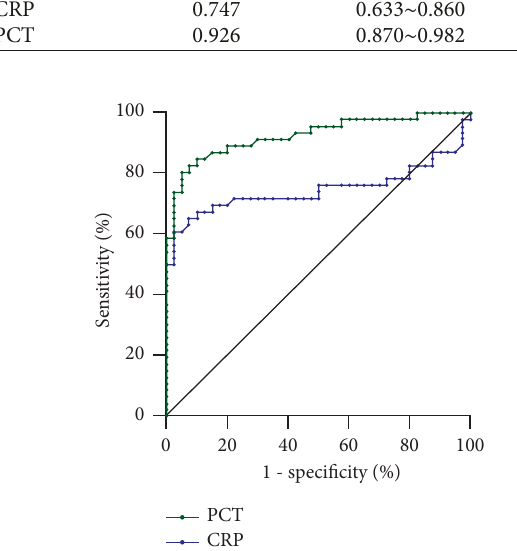
Figure 3: ROC curve of the diagnostic value of serum CRP and PCT levels for acute simple lower urinary tract